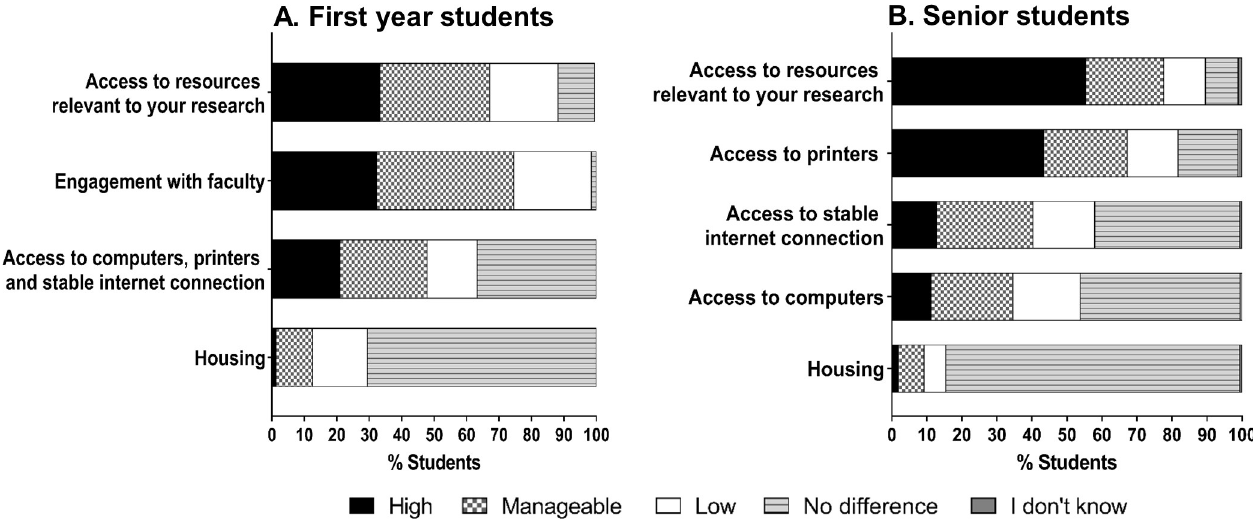
Fig 3. Negative impacts of COVID-19-related university closure. Students were asked to indicate the level of negative impact the university closure had on each item listed. Responses from (A) first year students (n = 71) and (B) senior students (n = 193) are shown.